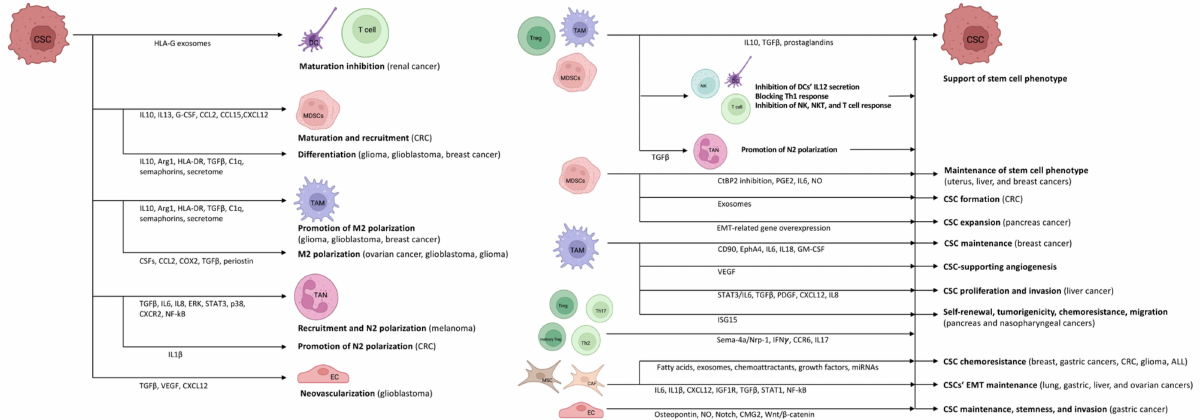
Figure 2. There is an intense association between CSCs and the inflammatory TME. CSCs are able to use immune-competent cells to their own advantage. At the same time, inflammatory TME cells promote the survival of CSCs. Green arrows indicate a stimulatory effect, while the red arrow indicates inhibition. The figure was partly created with